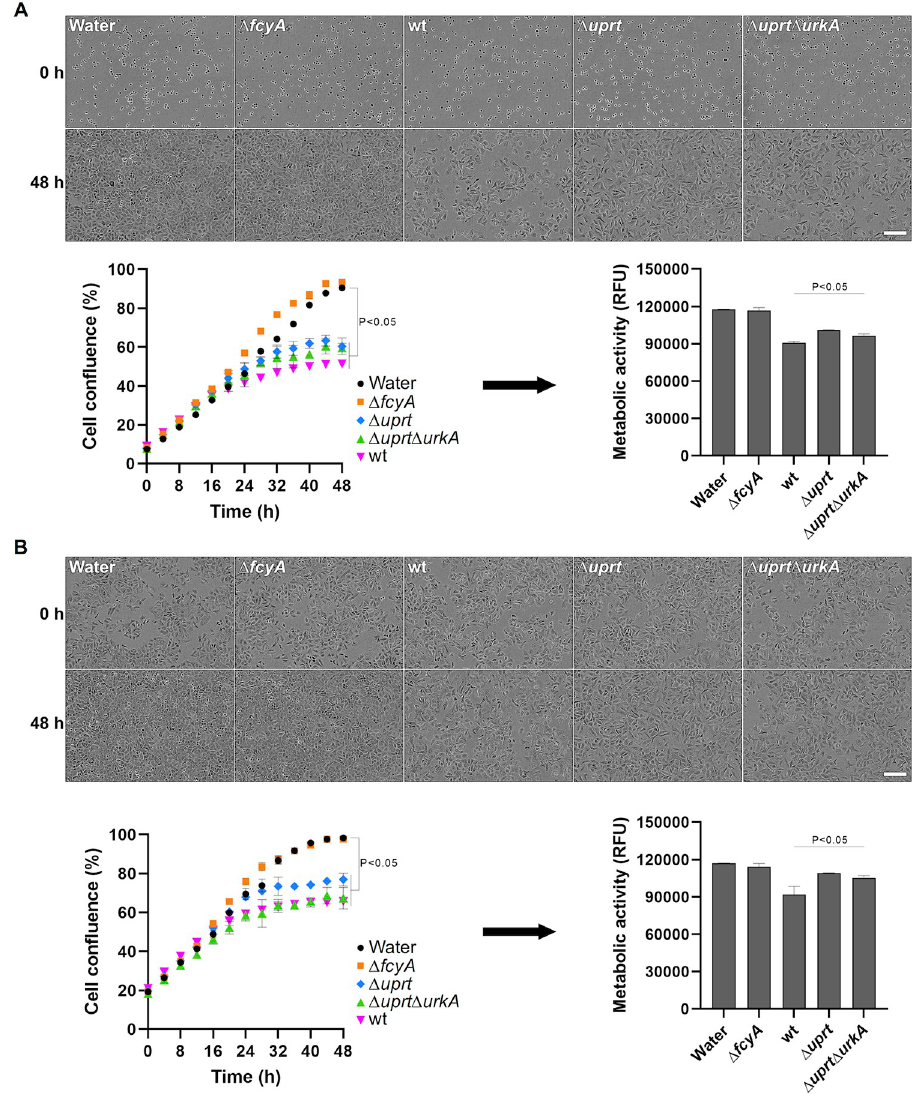
Fig 4. Fungal supernatants containing 5FC-derived antimetabolites compromise proliferation of mammalian cells. Microscopy-assisted analyses and confluence measurements of A549 cells exposed to 5FC treatment derived fungal culture supernatants were performed to determine potential toxic effects. In addition, a resazurin-based assay was carried out after 48 h to measure the metabolic activity of cells. Analyses were performed for cells challenged with the supernatants right after seeding them (A) and after cells’ adherence (B) . Scale bars: 200 μ m. RFU, Relative Fluorescence